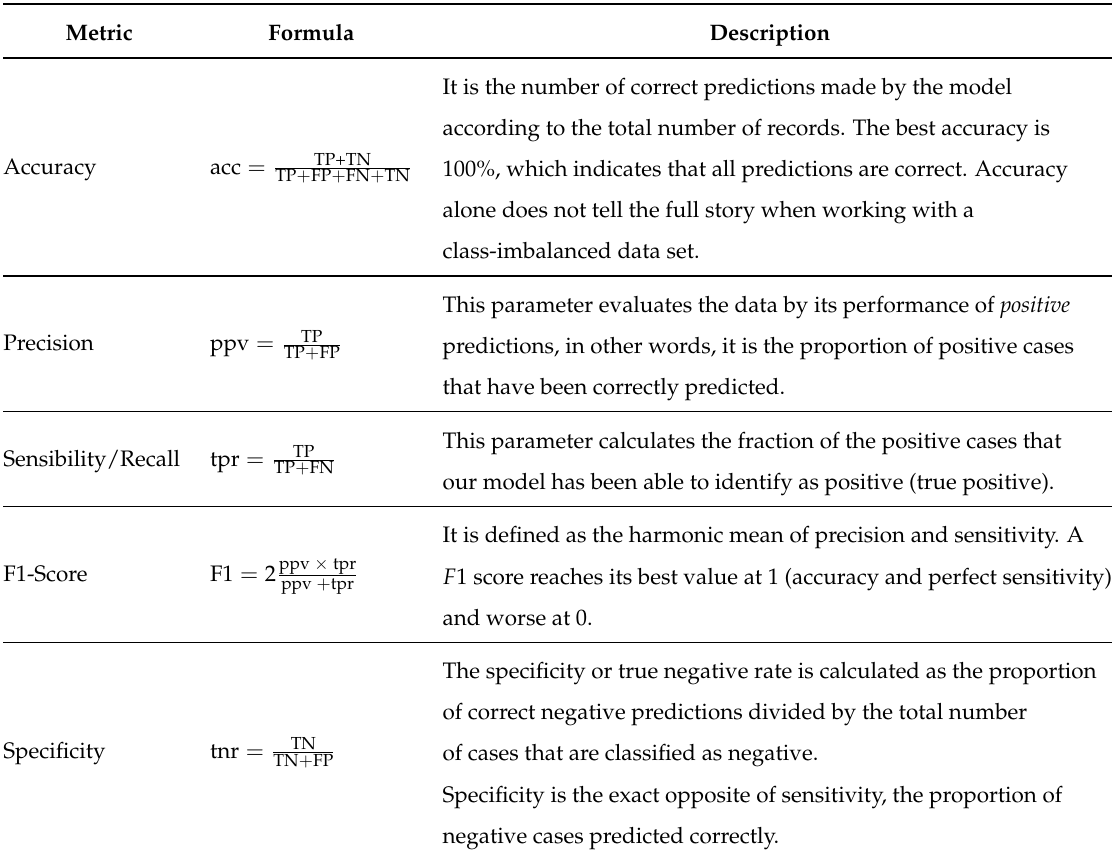
Table 2. Metrics for evaluating binary classification